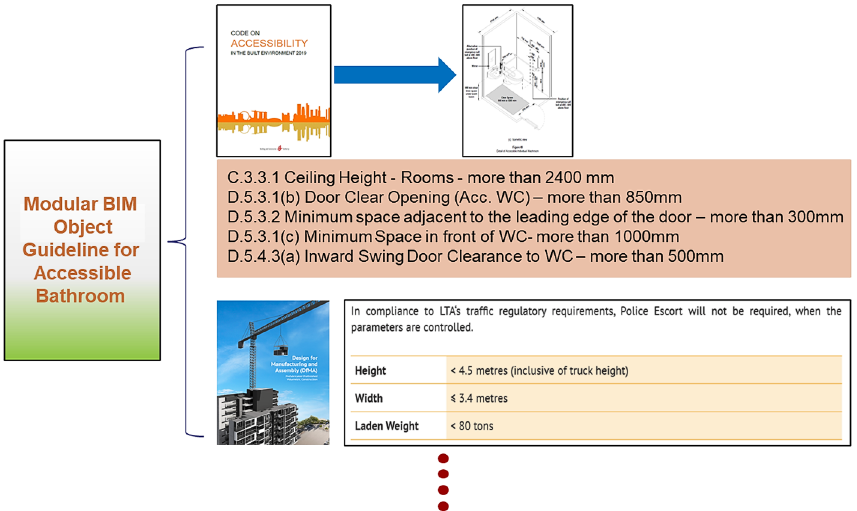
Figure 6. Modular BIM object guideline for accessible